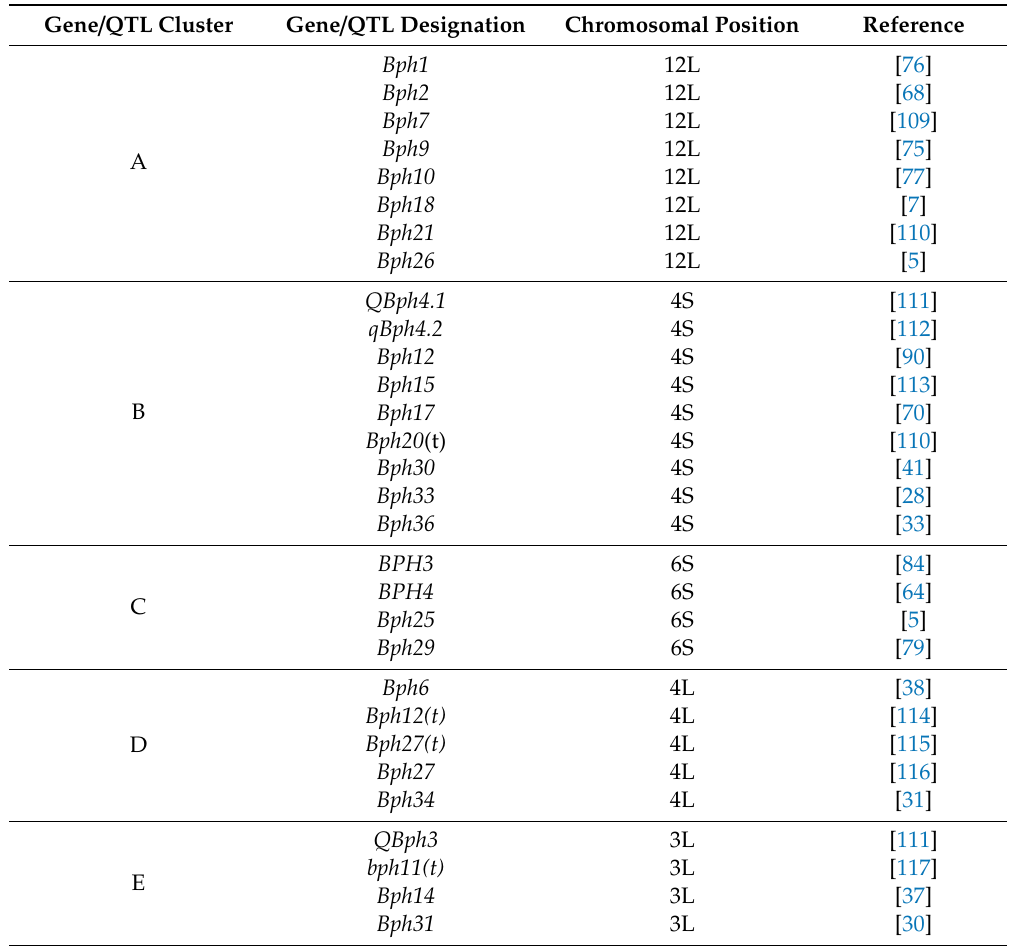
Table 2. List of some BPH resistance genes / quantitative trait loci (QTLs) and their clusters. Gene / QTL